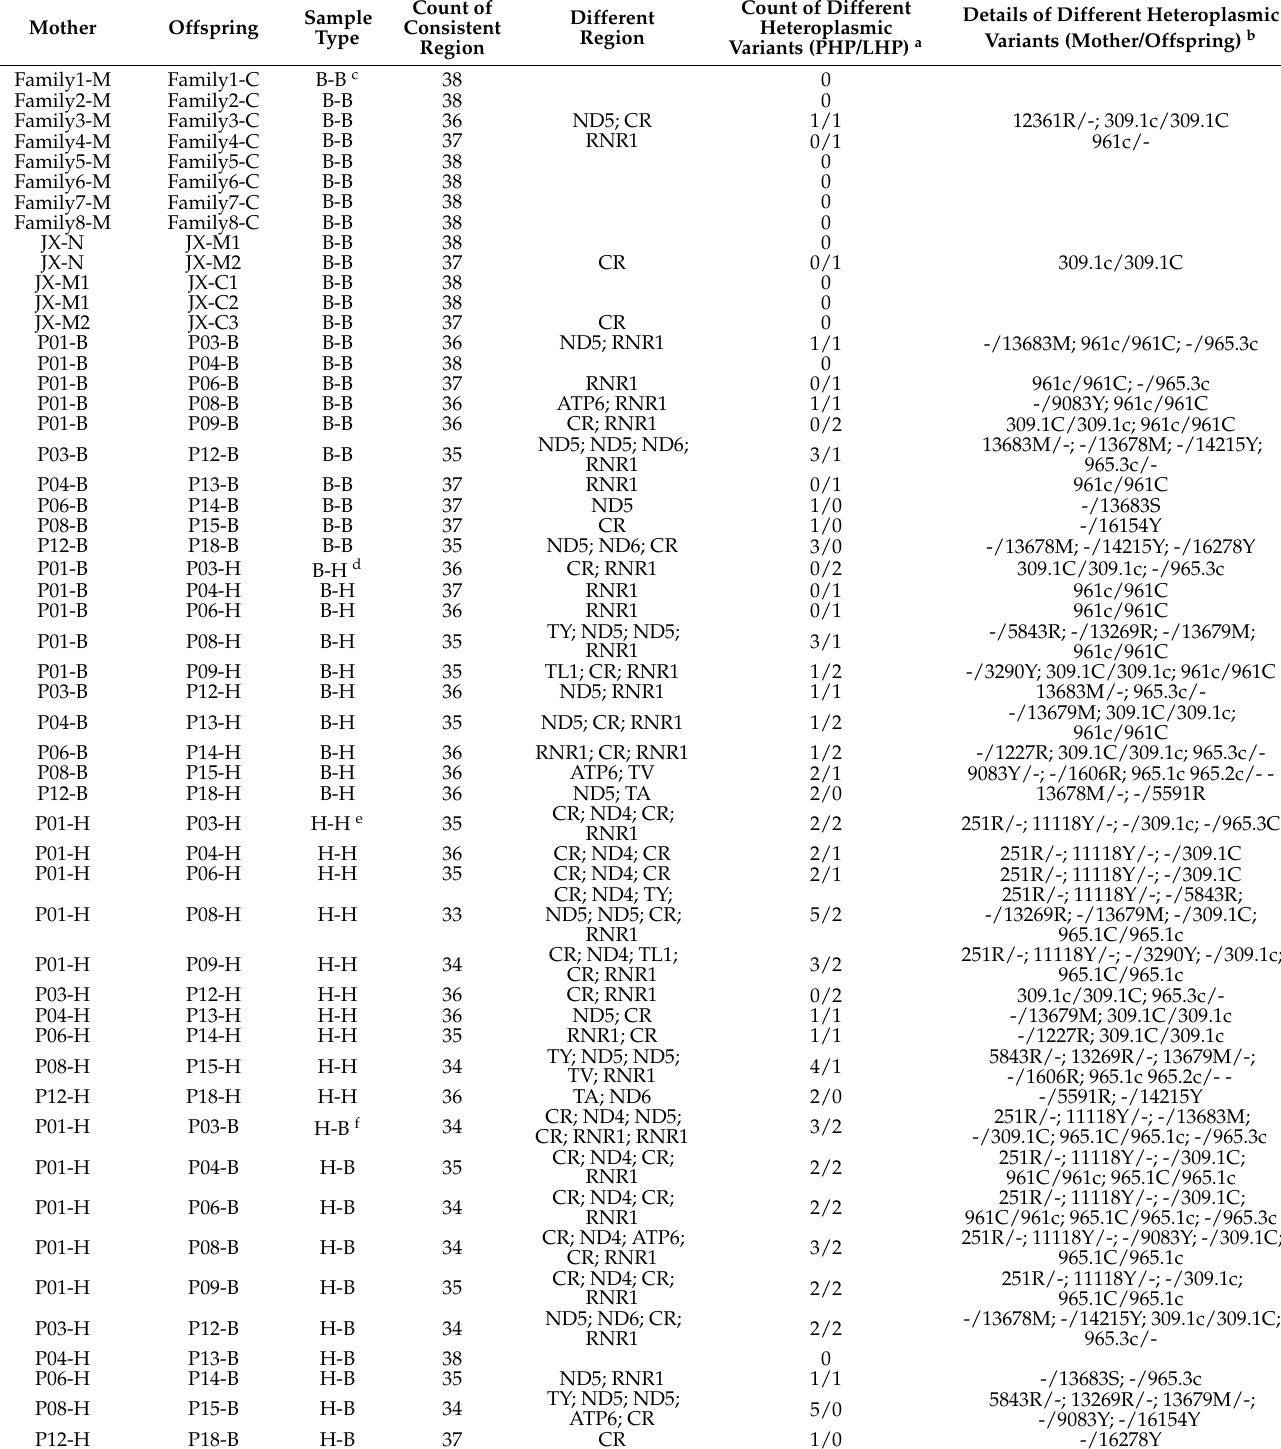
Table 5. Different regions and different heteroplasmic variants between the mtDNA haplotypes of mother and offspring